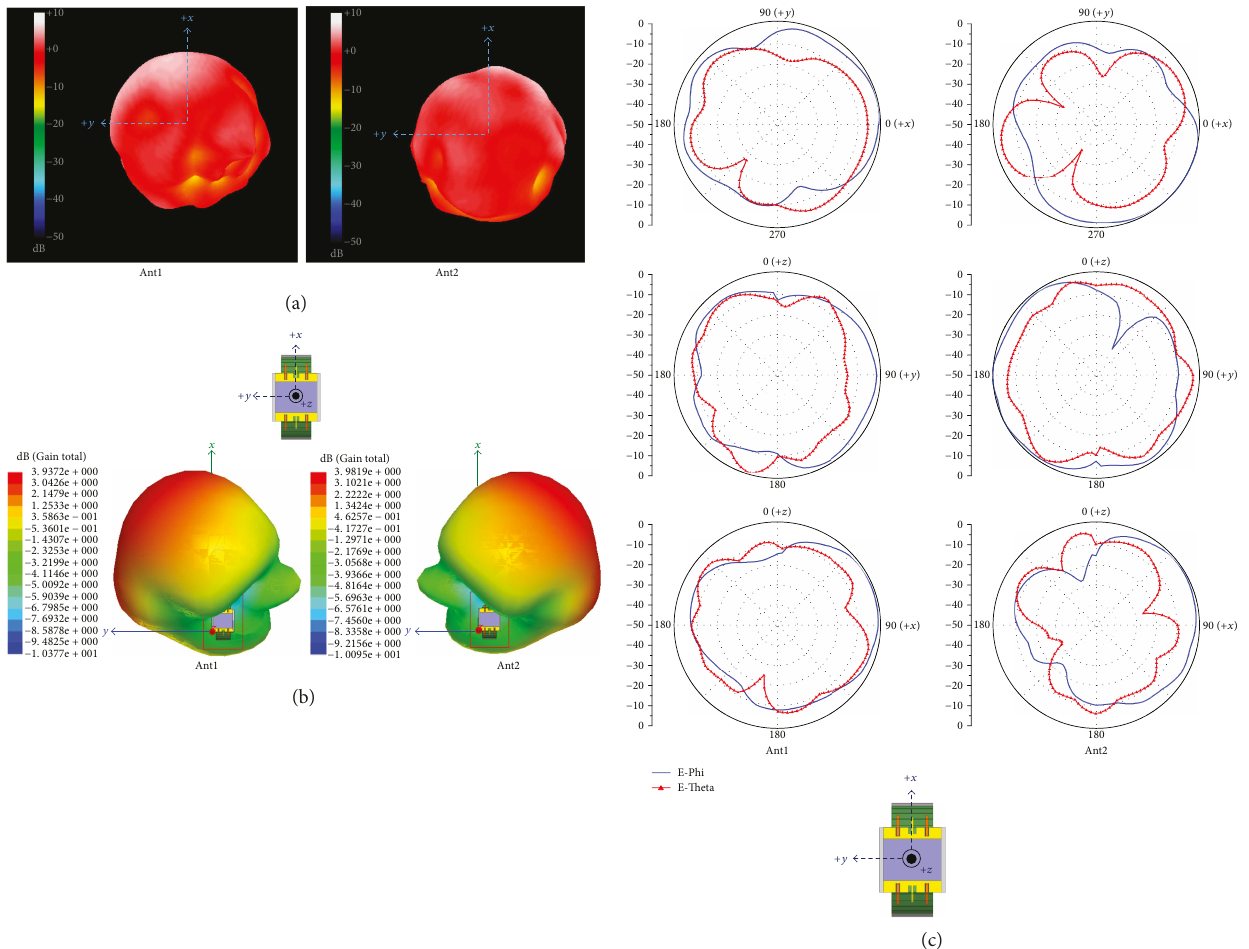
Figure 9: (a) Measured and (b) simulated 3D radiation patterns for the four-element MIMO antenna in free space (at 5.5 GHz). (c) Measured 2D radiation patterns (at